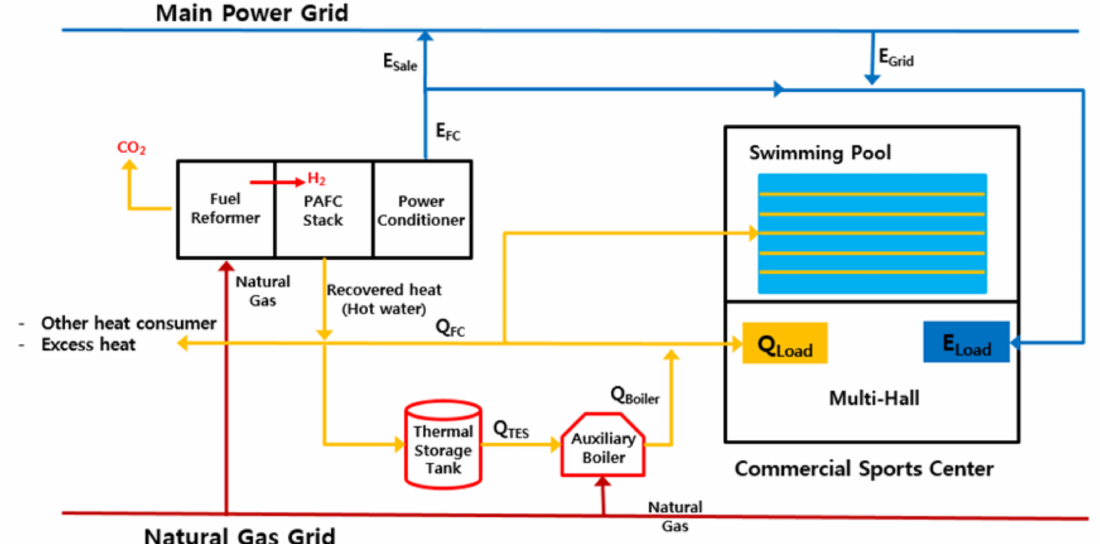
Figure 1. Configuration of the designed FC-CHP